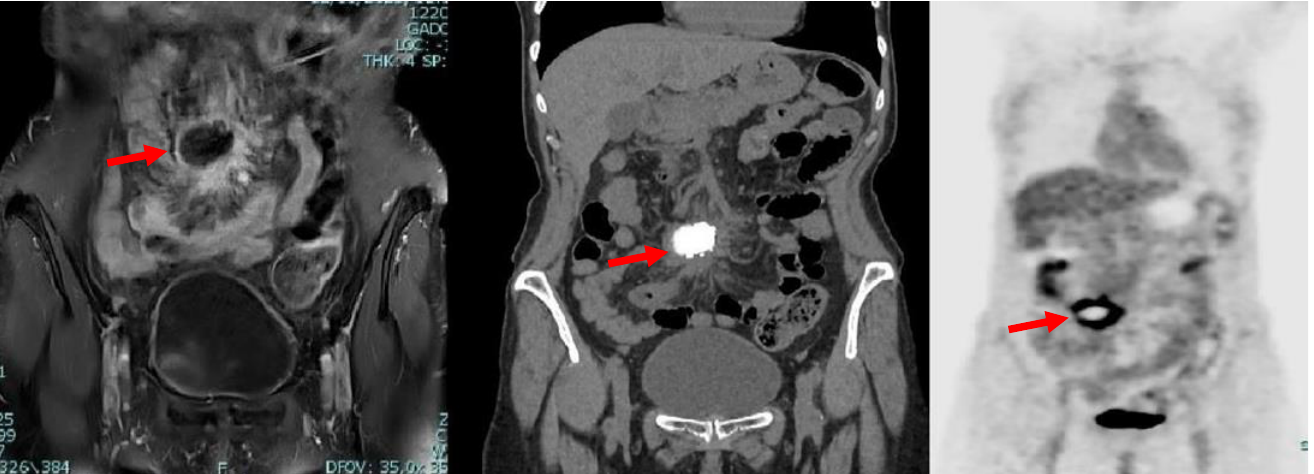
Figure 2. Coronal MRI ( left ), CT ( middle ) and PET ( right ) scans showing the presence, in mesogastrium, of a nodular mass (red arrows) with contrast enhancement at MRI and internal calcifications at CT, with thickened mesenterial fat and significant uptake of the radiotracer at PET-CT.